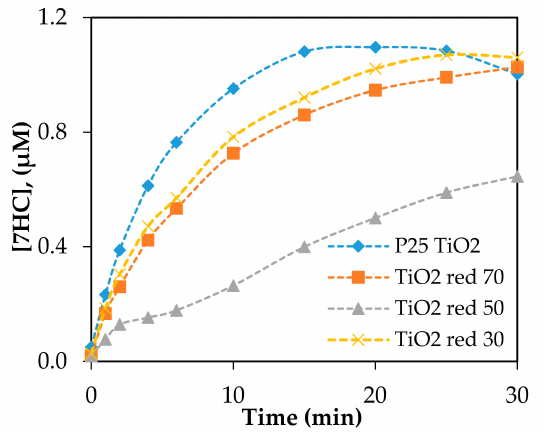
Figure 7. The production of 7HC by reduced P25 TiO 2 photocatalysts irradiated at 350 nm. Catalyst loading was 0.10 g / L; [COU] = 125 µ M.